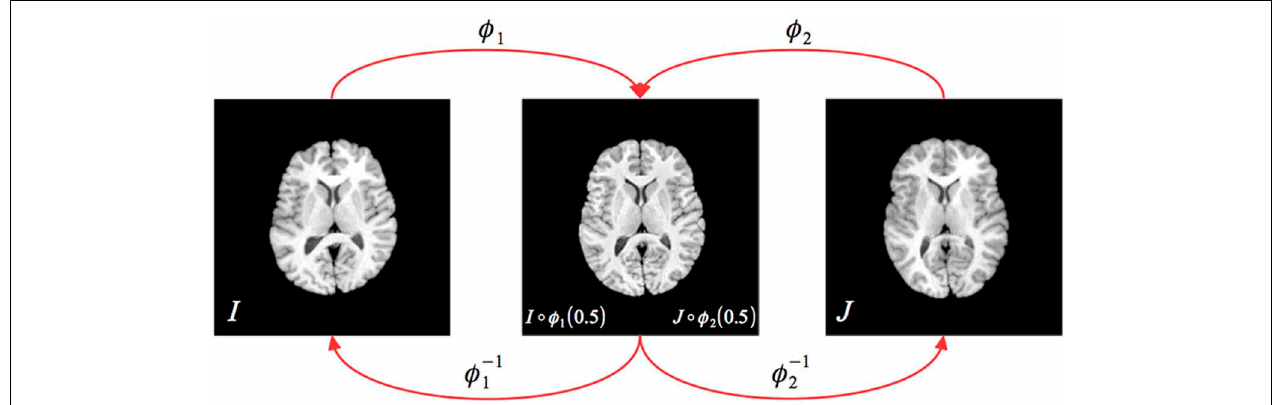
iteration is determined from the metric field gradient taken at the (cid:7) (cid:6) . The full forward and I ◦ φ 1 ( 0 . 5 ), J ◦ φ 2 ( 0 . 5 ) midway point, i.e., ∇ (cid:3) ∼ inverse transforms are found through composition, i.e., φ = φ 1 ◦ φ − 1 2 and φ − 1 = φ 2 ◦ φ − 1 1